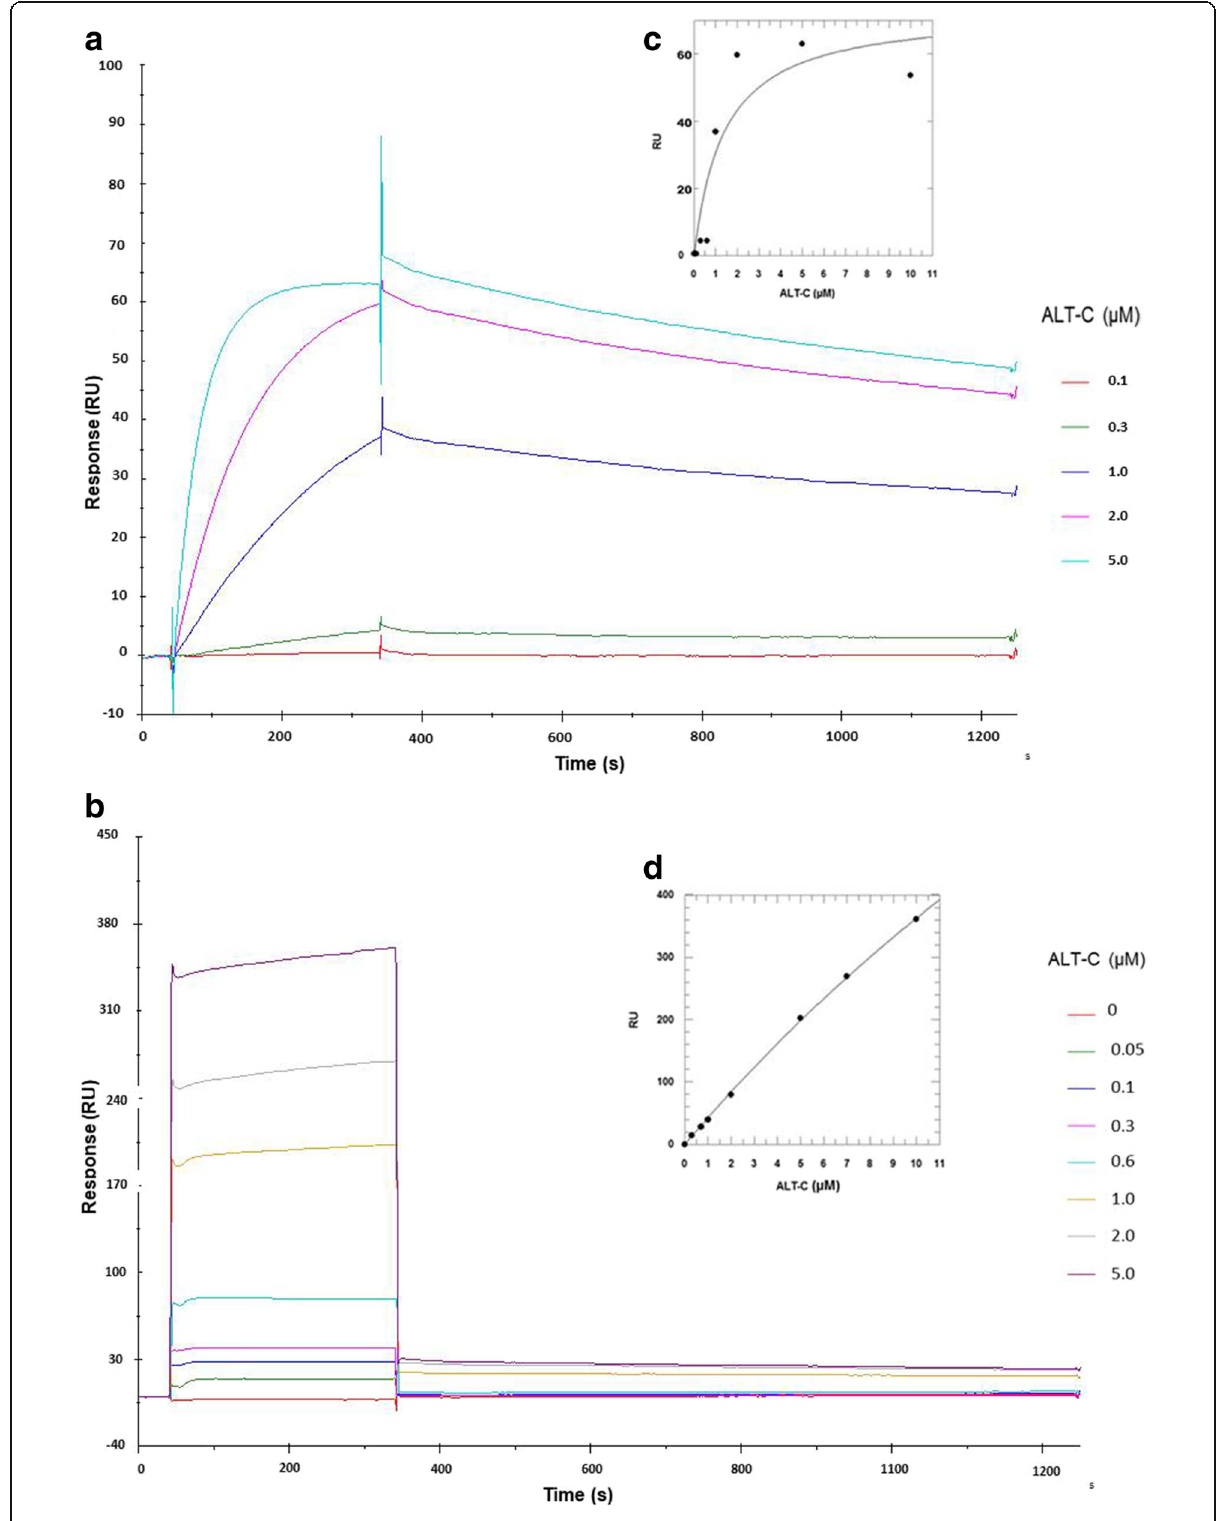
Fig. 1 Characteristics of ALT-C binding to α 2 β 1 integrin or collagen type I (Col I). Representative sensorgrams and dose-dependent binding of ALT-C (0.0 – 5.0 μ M) measured by surface plasmon resonance (SPR): ( a ) to α 2 β 1 integrin; and ( b ) to Col I. Kinetic curves were analyzed using the 1:1 binding model by GraFit 7 software for: ( c ) α 2 β 1 integrin; and ( d ) Col